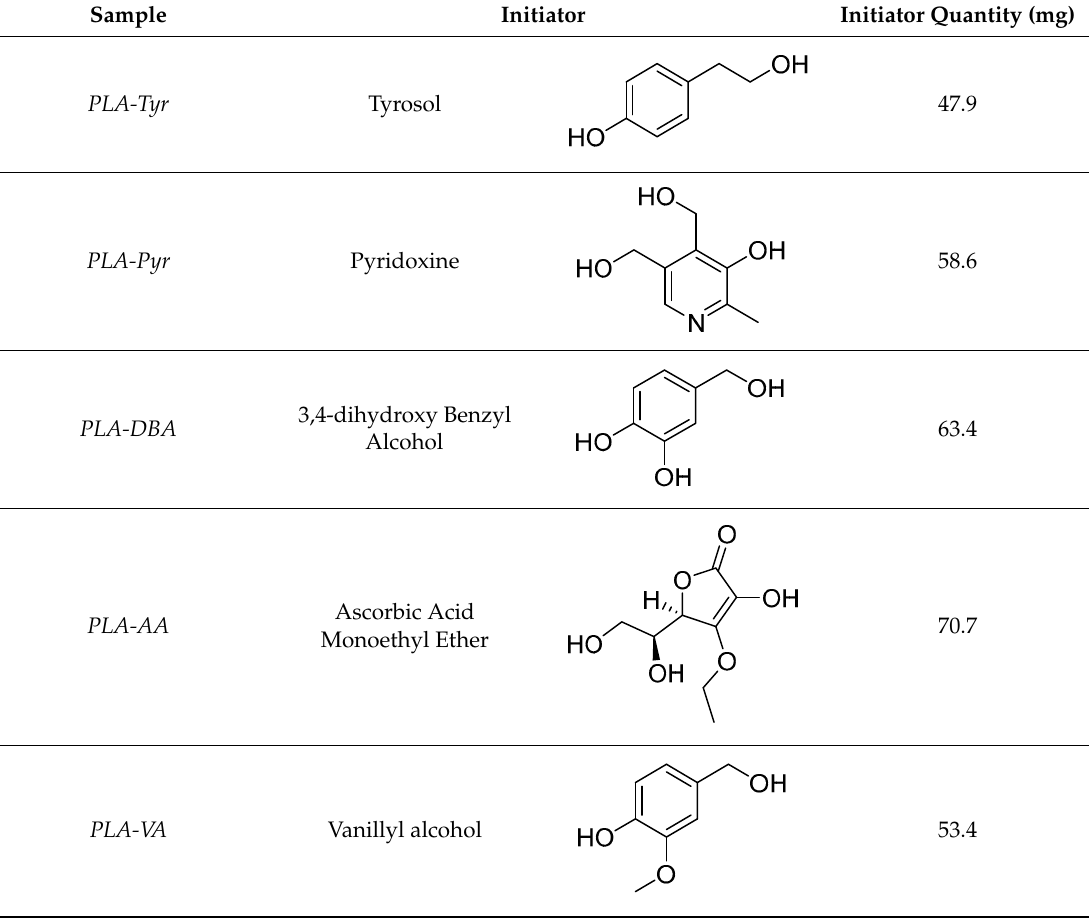
Table 1. Synthesized